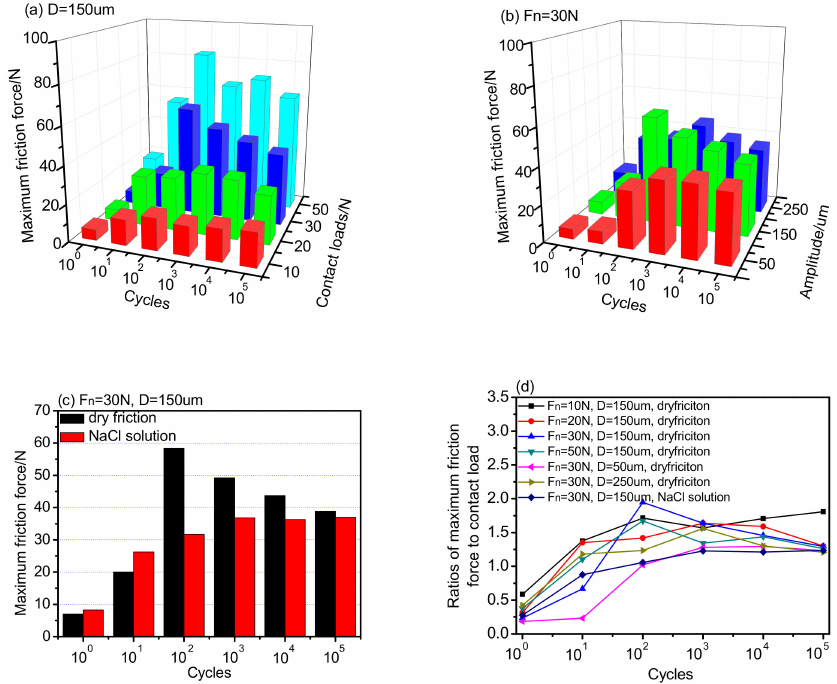
Figure 4. ( a – c ) The maximum friction force and ( d ) its ratio to normal force as a function of fretting